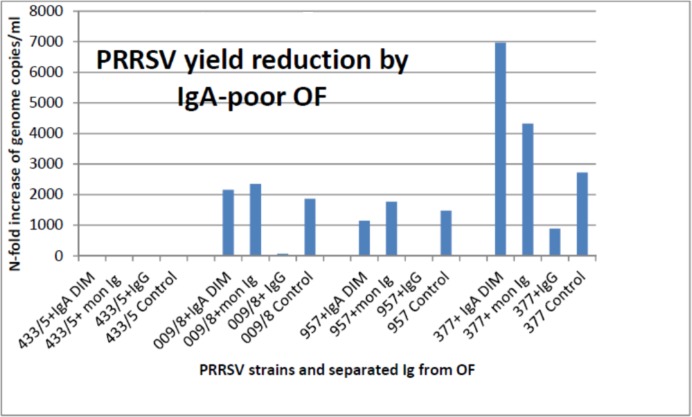
Yield reduction assay in PAM, test 2.Ig fractions were separated from an OF pool showing little if any IgA response (s/p IgA: 0.63; s/p IgG: 1.54). These IgA-low fractions exerted by far less or no antiviral activity on strains 009/8, 377 and 957, compared with the IgG fraction, whereas strain 433/5 replicated very poorly (P< 0.1, tendency).